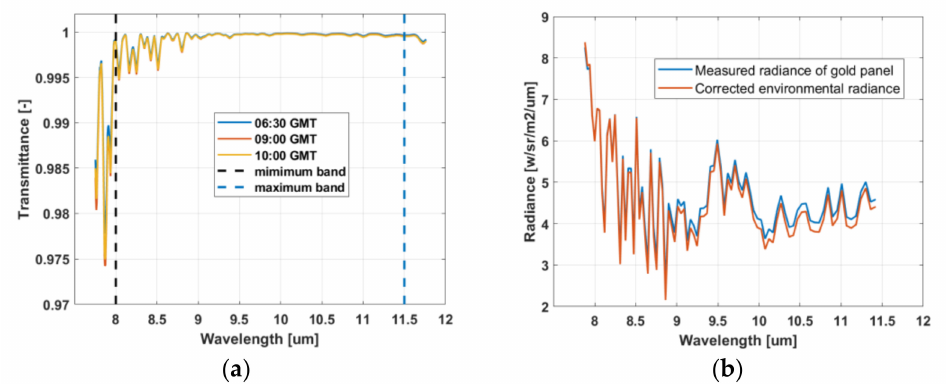
Figure 10. ( a ) Simulated atmospheric transmittance by MODTRAN ® 5.2; ( b ) comparison between the corrected environmental radiance and the measured radiance of the gold-coated